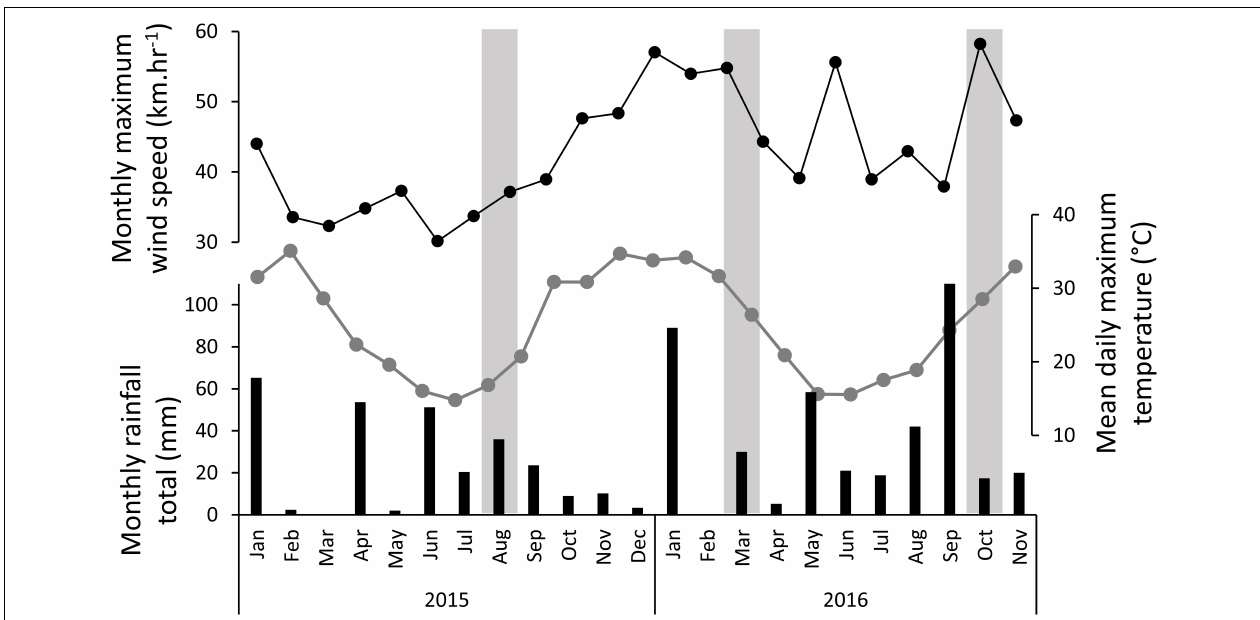
FIGURE 2 | Climate variables throughout experiment showing monthly rainfall totals (black bars), the mean daily maximum air temperature for each month (connected grey dots), and the maximum wind speed recorded in each month (connected black dots). The vertical grey bars signify the months in which the experiment was